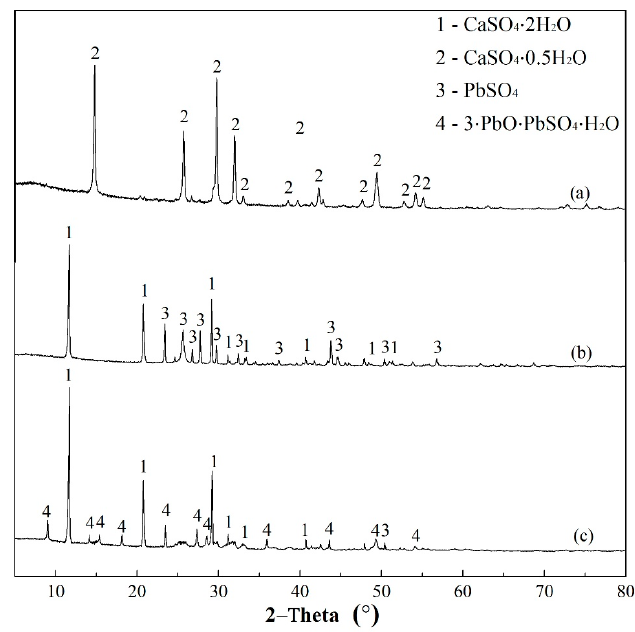
Figure 10. XRD patterns of materials before and after adsorption at different pH values: ( a ) CSHW, ( b ) product acquired at pH = 5.42, and ( c ) product acquired at pH = 8.08. Crystals 2017 , 7 , 270